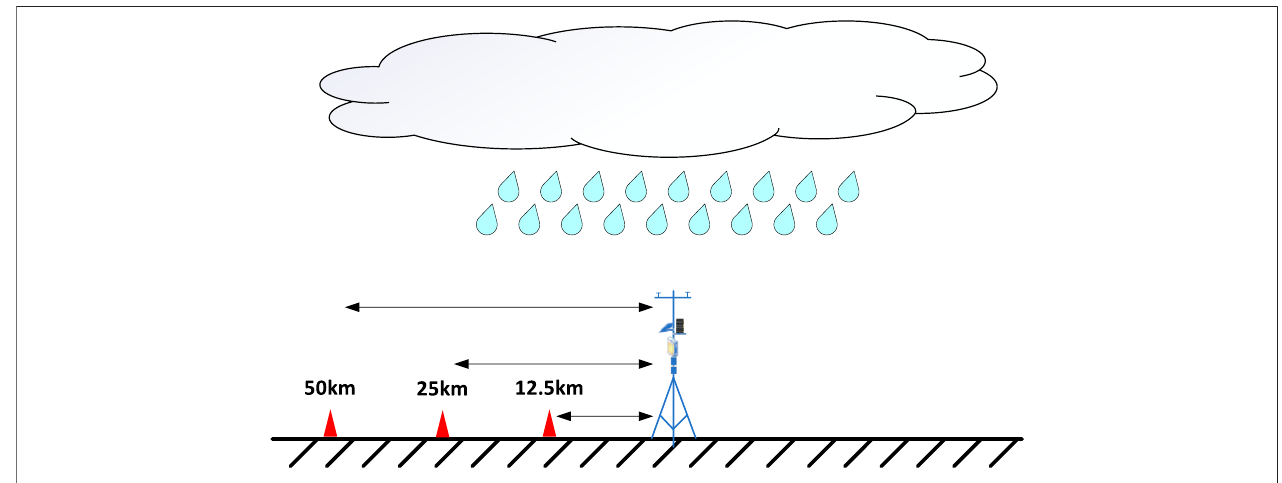
FIGURE 2 | The graph of the weather station in the fi gure represents the NWS, and the three red triangles represent the boundaries of the sampling ranges for the small-scale input, the medium-scale input, and the large-scale input. The sampling area is a rectangular area centered on the NWS at a horizontal resolution of 0.005 ° .